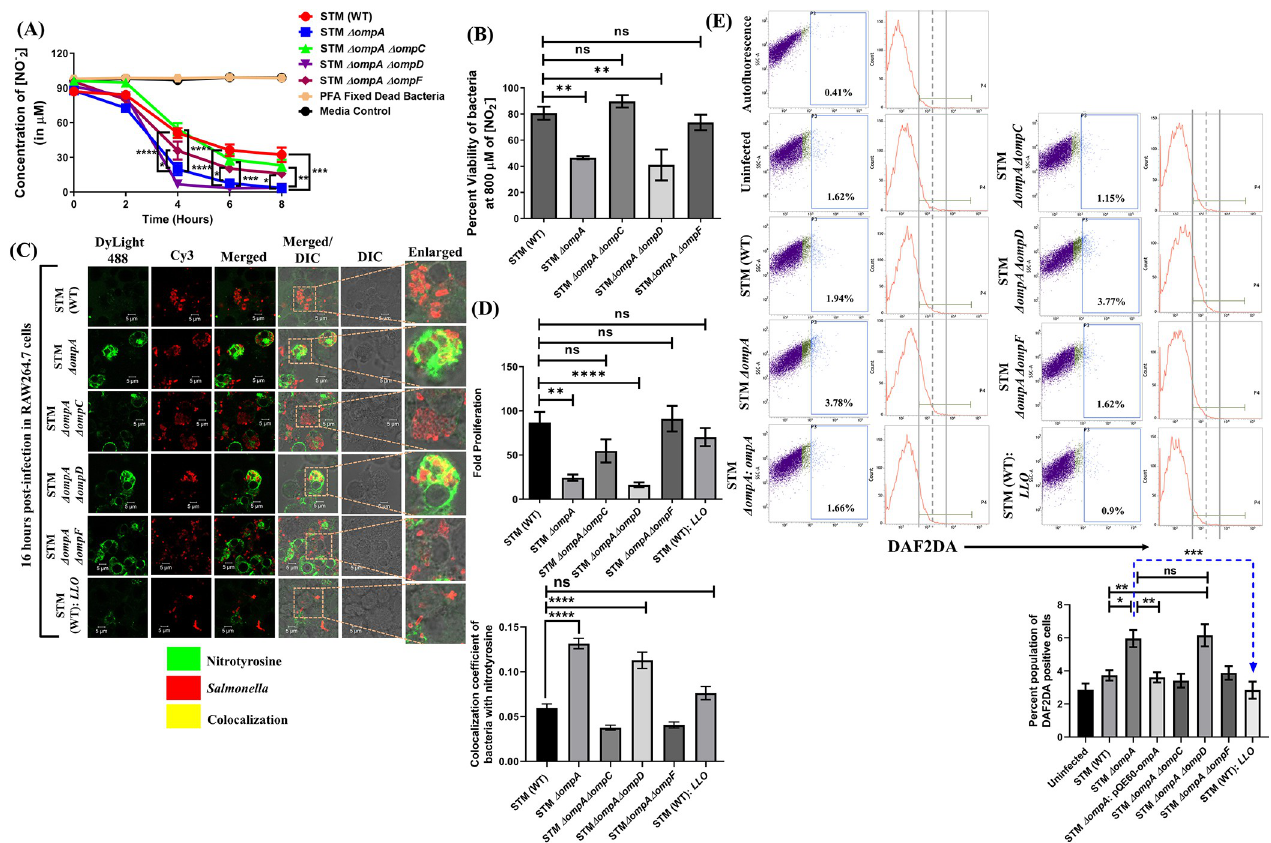
Fig 7. In the absence of OmpA, outer membrane protein F (OmpF) enhances the susceptibility of Salmonella against the nitrosative stress of RAW264.7 cells. (A) In vitro nitrite uptake assay of STM (WT), Δ ompA , Δ ompA Δ ompC , Δ ompA Δ ompD , Δ ompA Δ ompF , & PFA fixed dead bacteria (n = 3, N = 6). (B) In vitro viability assay of STM (WT), Δ ompA , Δ ompA Δ ompC , Δ ompA Δ ompD , & Δ ompA Δ ompF in the presence of acidified nitrite at 12 hours post-inoculation using resazurin solution (n = 3, N = 3). (C) Immunofluorescence image of STM (WT), Δ ompA , Δ ompA Δ ompC , Δ ompA Δ ompD , Δ ompA Δ ompF , & (WT): LLO (MOI 20) in RAW264.7 cells to study the recruitment of nitrotyrosine. The colocalization coefficient of bacteria with nitrotyrosine was represented as a vertical bar graph (n � 60, N = 3). Scale bar = 5 μ m. (D) Calculating the fold proliferation of STM (WT), Δ ompA , Δ ompA Δ ompC , Δ ompA Δ ompD , & Δ ompA Δ ompF , & (WT): LLO respectively (MOI 10) in RAW264.7 cells (n = 3, N = 2). (E) Estimating the level of intracellular NO in RAW 264.7 cells infected with STM (WT), Δ ompA , Δ ompA :pQE60- ompA , Δ ompA Δ ompC , Δ ompA Δ ompD , Δ ompA Δ ompF , and (WT): LLO respectively at MOI 10 using DAF-2DA [5 μ M] by flow cytometry. Both dot plots (SSC-A vs. DAF-2 DA) and histograms (Count vs. DAF-2 DA) were represented. The percent population of DAF-2DA positive macrophages has been represented in a bar graph (n � 3, N = 5). Data are represented as mean ± SEM. (P) � < 0.05, (P) �� < 0.005, (P) ��� < 0.0005, (P) ���� < 0.0001, ns = non-significant, (Unpaired student’s t test in A and one-way ANOVA in B, C, D, E)